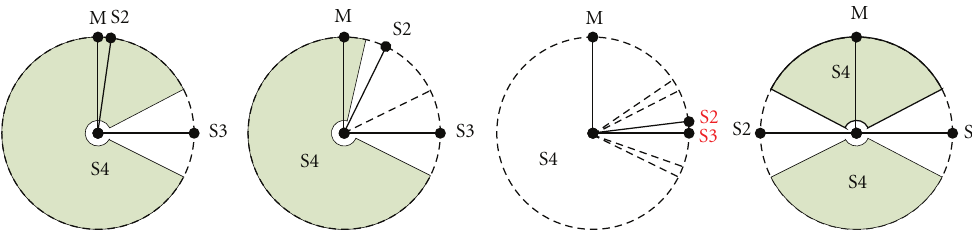
Figure 18: Appropriate constellations of four satellites for the usage of a Master-Slave approach (M—Master, S2,3,4—Slaves, with φ Master = φ slaves ). The coloured fields indicate appropriate positions of S4. In the third case there is an inappropriate constellation for Master-Slave, since S2 and S3 are highly